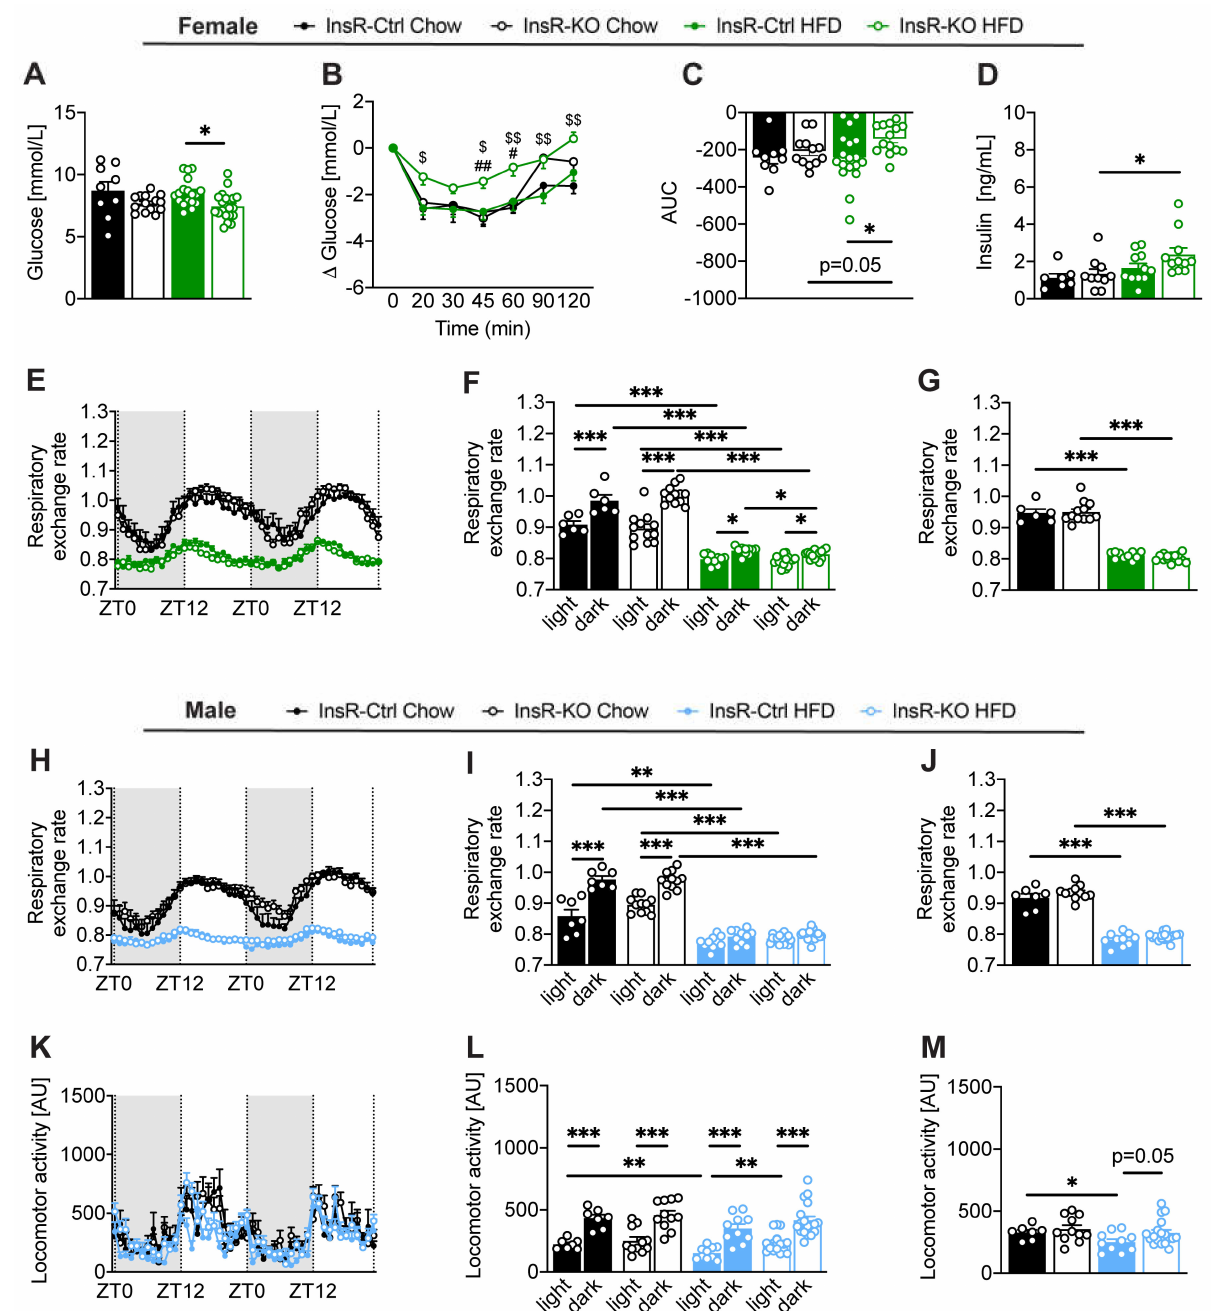
Figure 2. Loss of microglial InsR leads to impaired glucose homeostasis in obese female mice. ( A – D ) Female InsR-Ctrl and InsR-KO mice fed a Chow diet (black) or HFD (green) data for ( A ) fasted blood glucose, following 11 weeks of diet exposure ( n = 9–19). InsR-KO female mice had lower blood glucose compared to InsR-Ctrl mice during obesity. ( B , C ) insulin tolerance glucose concentration presented as ( B ) delta glucose and ( C ) AUC data ( n = 9–19). Delta glucose and AUC in InsR-KO females were higher compared to InsR-Ctrl mice during obesogenic conditions; ( D ) fasted plasma insulin, following 11–12 weeks of diet exposure ( n = 7–11); ( E – G ) Female InsR-Ctrl and InsR-KO mice fed a Chow diet (black) or HFD (green) data for the respiratory exchange rate (RER) presented as ( E ) 48 h plot, ( F ) 48 h light and dark phase and ( G ) 24 h ( n = 6–16). Loss of microglial InsR led to lower RER during the dark phase in obesogenic condition; ( H – J ) Male InsR-Ctrl and InsR-KO mice fed a Chow diet (black) or HFD (blue) data for respiratory exchange rate presented as ( H ) 48 h